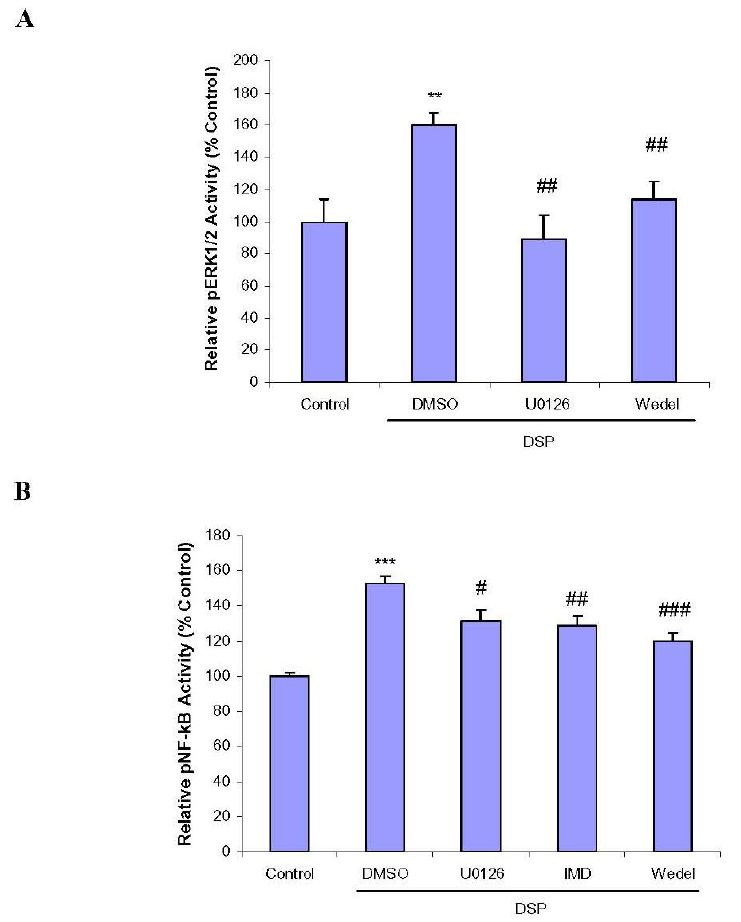
FIGURE 6. Interaction of the activation of ERK and NF-κB in DSP-treated human VSMCs. Serum-starved cells were treated with 0.2 μl/ml of DSPs for 1 or 3 h. 10 μM of U0126, 5 μM of wedelolactone, or 30 nM of IMD-0354 were added to cells 30 min prior to treatment with DSPs. Bar graphs show the effects of inhibitors on DSP-induced phosphorylation of ERK1/2 (A) and phosphorylation of NF-κB (B) as determined by phosphoELISA. Data represent mean ± S.E.M. ** p < 0.01, *** p < 0.001 vs. control; # p < 0.05, ## p < 0.01, ### p < 0.001 vs. DMSO; p = phosphorylated; Wedel = wedelolactone; IMD =